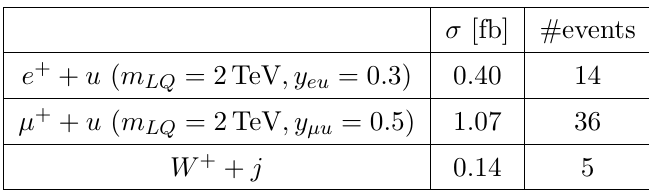
Table 2. Cross sections and number of expected events for an integrated luminosity of 36 fb (cid:0) 1 in the lepton+jet mass window 1950 GeV < m ‘j < 2050 GeV. These numbers do not include the charge conjugate process, that is